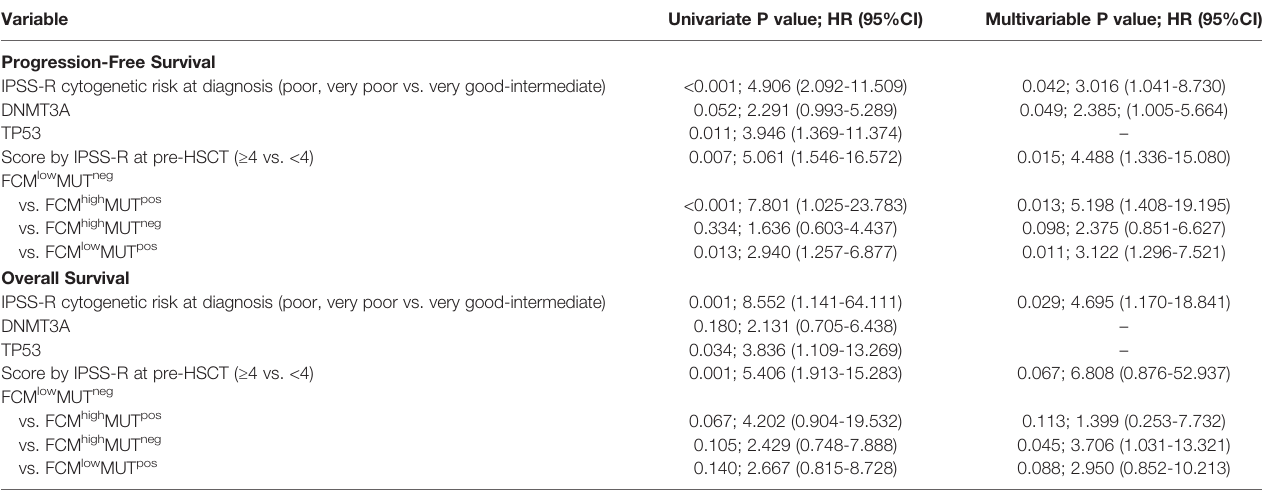
TABLE 3 | Univariate and multivariate analysis of prognostic factors for disease progression.